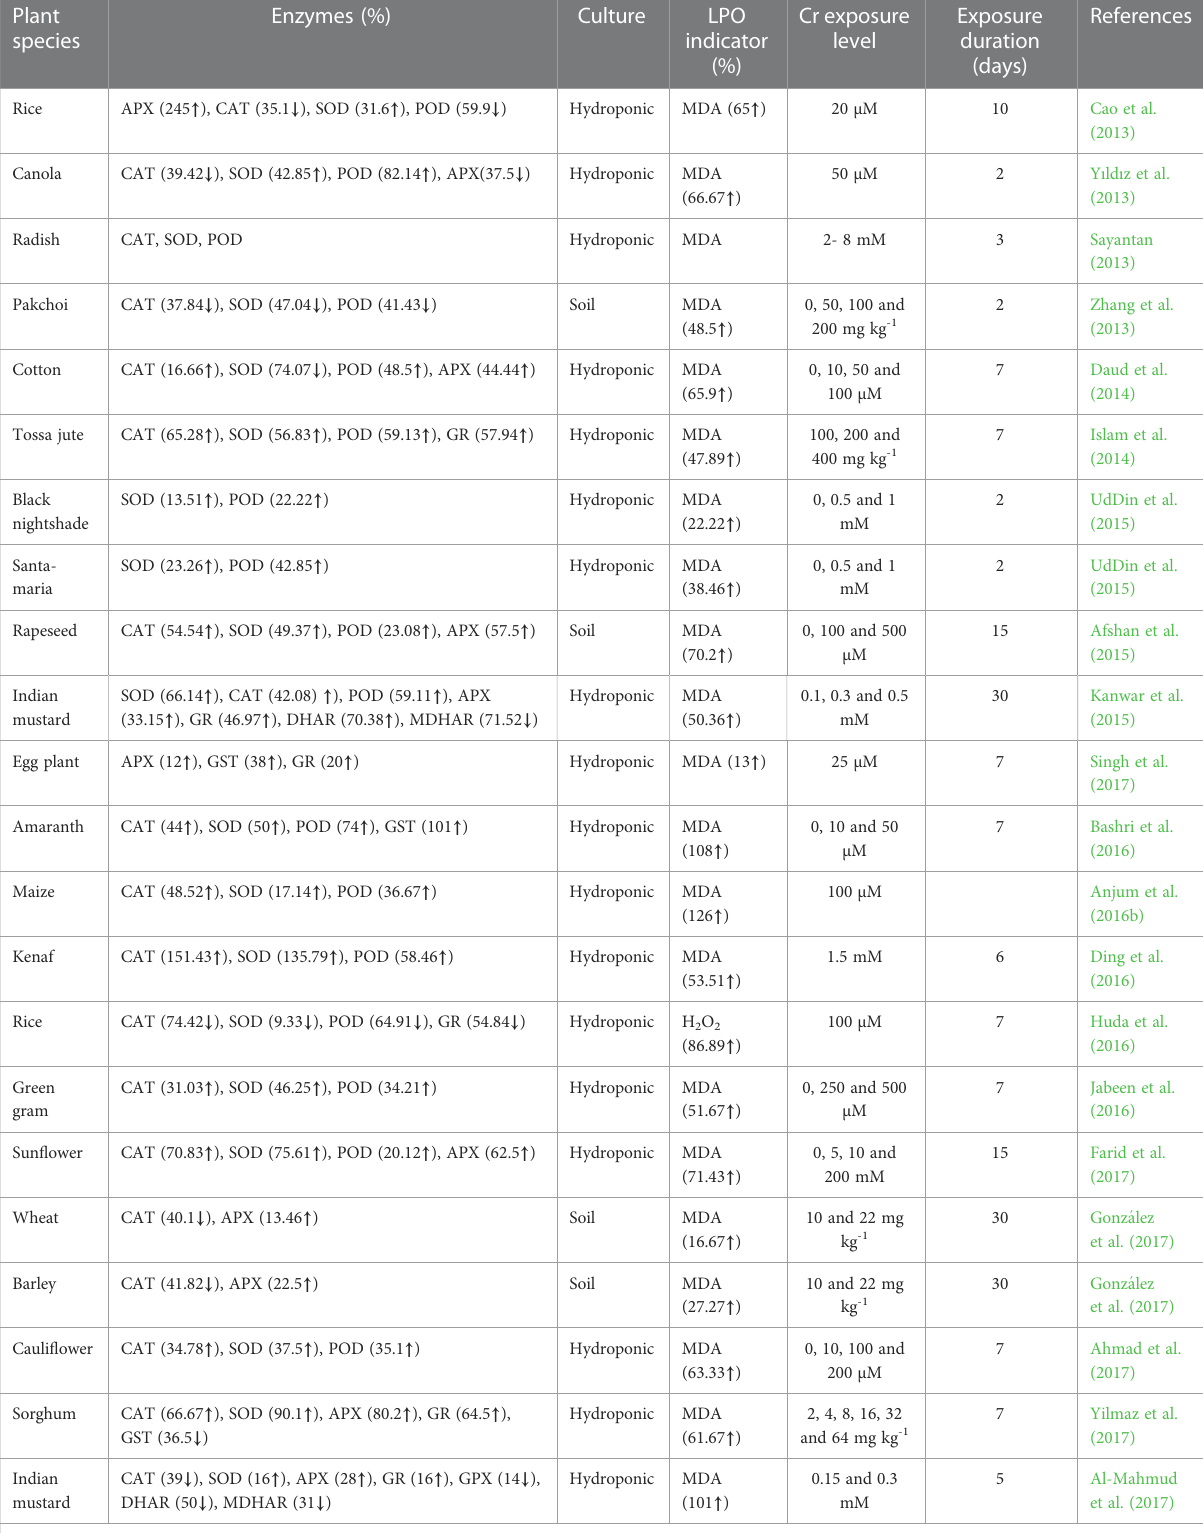
TABLE 2 Effects of chromium stress on activities of different antioxidant enzymes and lipid peroxidation in different plants. Plant species